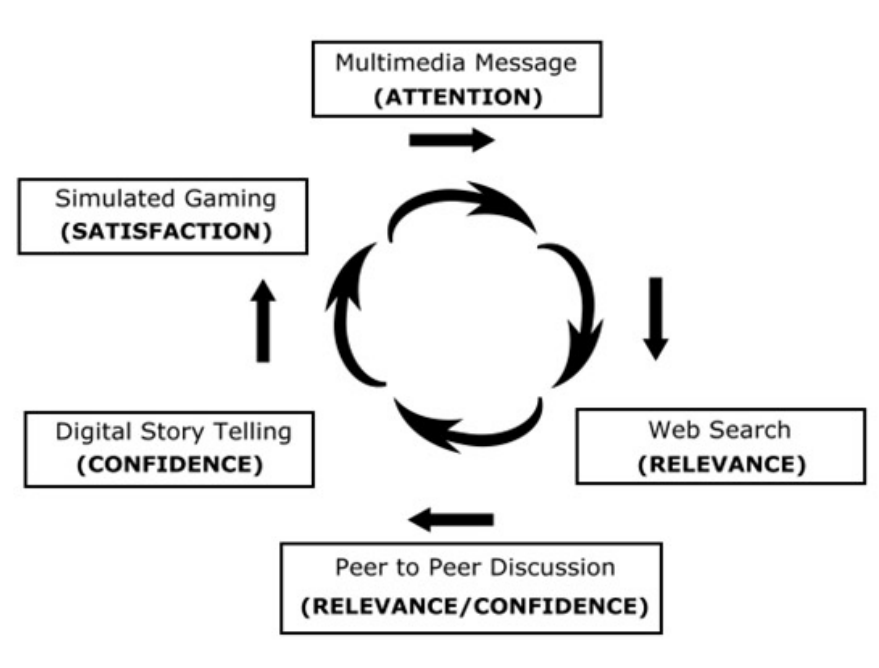
Figure 2. Learning Cycle in Shih’s Mobile Learning